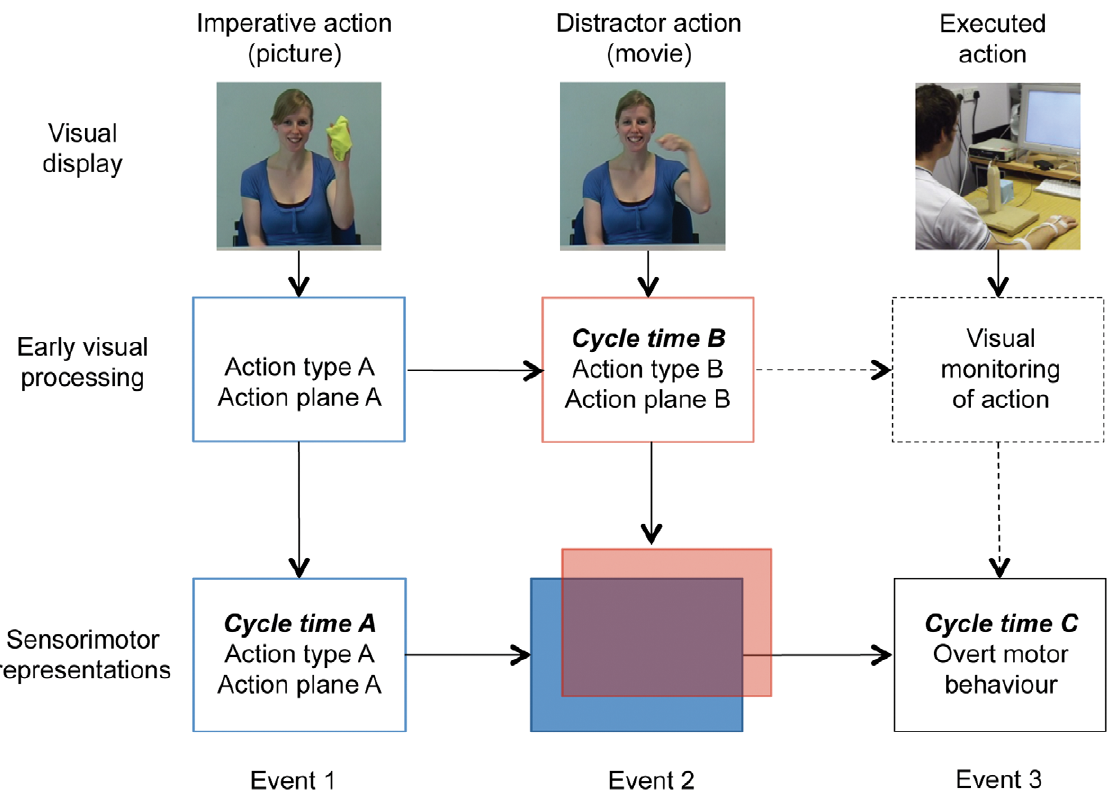
Figure 7. Hypothetical early-visual and sensorimotor processes during the three main events of an automatic imitation trial (for further details, see text). Event 1: Although the imperative picture did not specify execution speed, it is likely that the sensorimotor representation of the to-be-performed action included the habitual rhythm (cycle time A). Event 2: During presentation of the distractor movie, instructed and distractor actions are represented as two parallel and potentially competing sensorimotor streams. Event 3: The cycle time C during motor execution reflects the result of the biased competition for those two representations in Event 2. The dotted route indicates an alternative explanation of the imitation bias, via visual monitoring and related corrections during execution, for which no evidence was found in the present study.